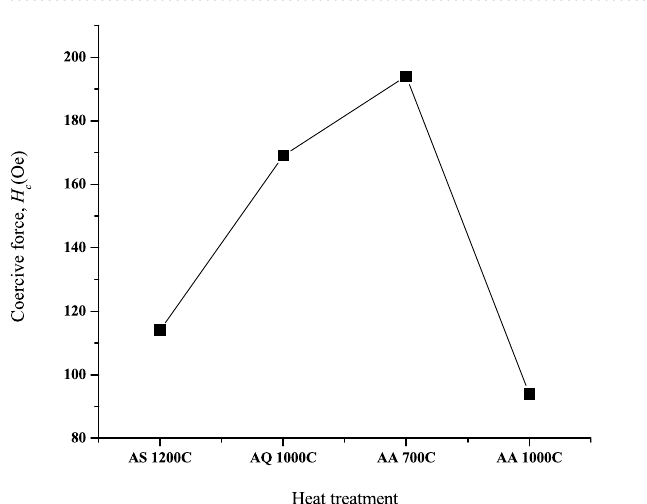
Figure 8. Domain wall prediction for sample after sintering at 1200 °C, after quenching at 1000 °C, after annealing at 700 and 1000 °C.